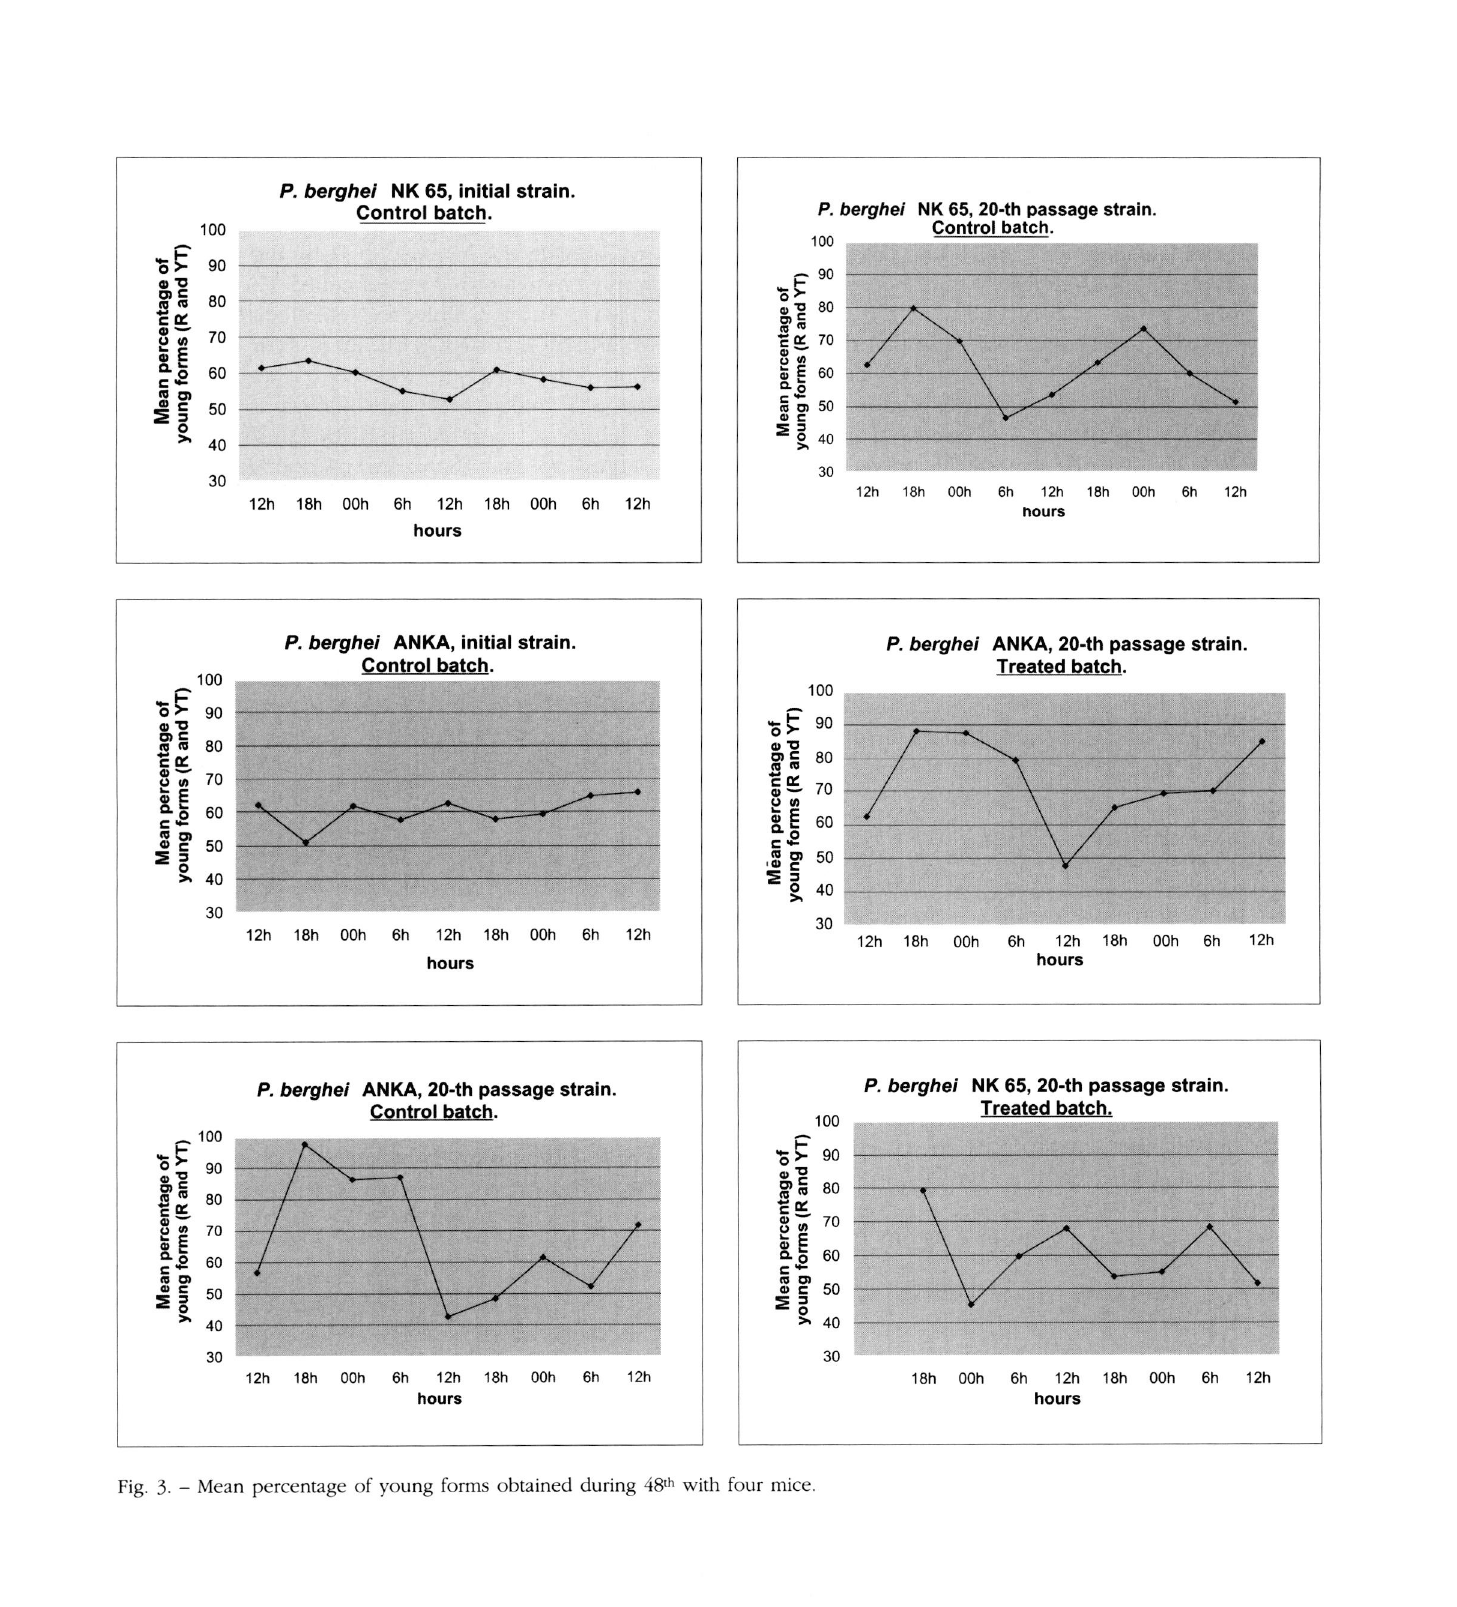
Fig. 3. - Mean percentage of young forms obtained during 48 th with four